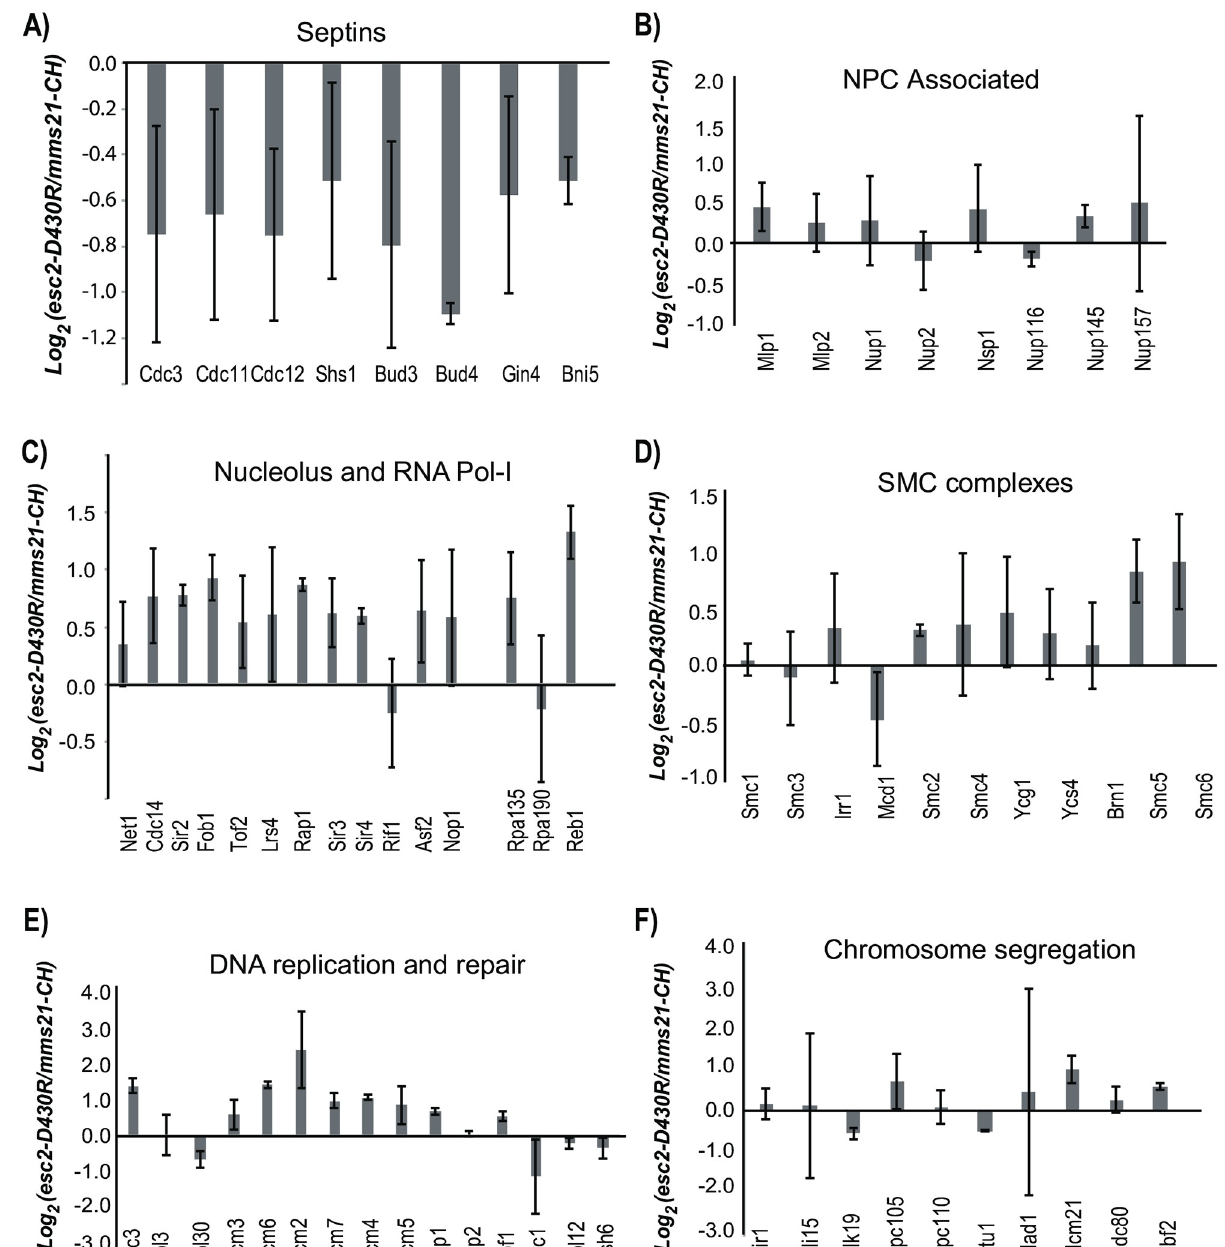
Fig 7. esc2-D430R and mms21-CH have similar effects on intracellular sumoylation. A) Septins, B) NPC associated, C) Nucleolus and RNA Pol-I, D) the SMC complexes, E) DNA replication and repair and F) Chromosome segregation. Log 2 ratios of comparing the relative abundance of each protein in the esc2-D430R and mms21-CH mutant are shown, along with error bars representing the standard deviation calculated using multiple unique peptides of the same protein (see experimental method for